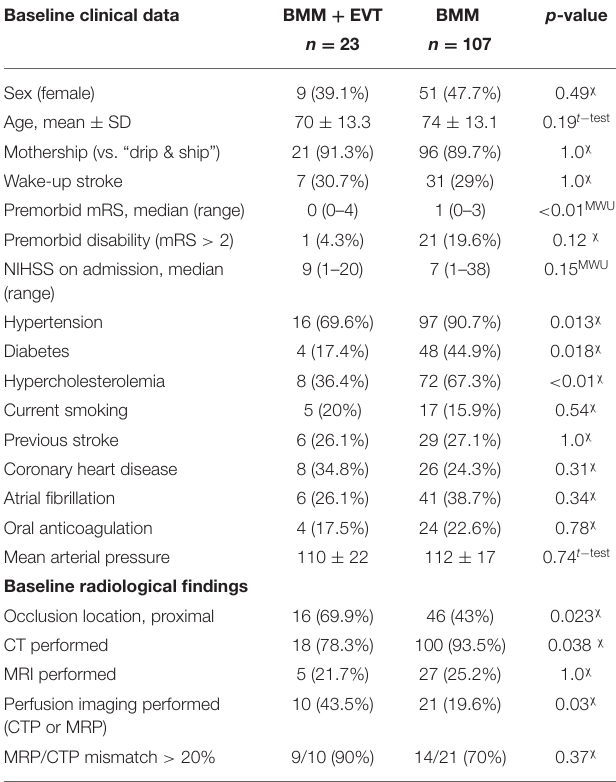
TABLE 1 | Baseline clinical and imaging